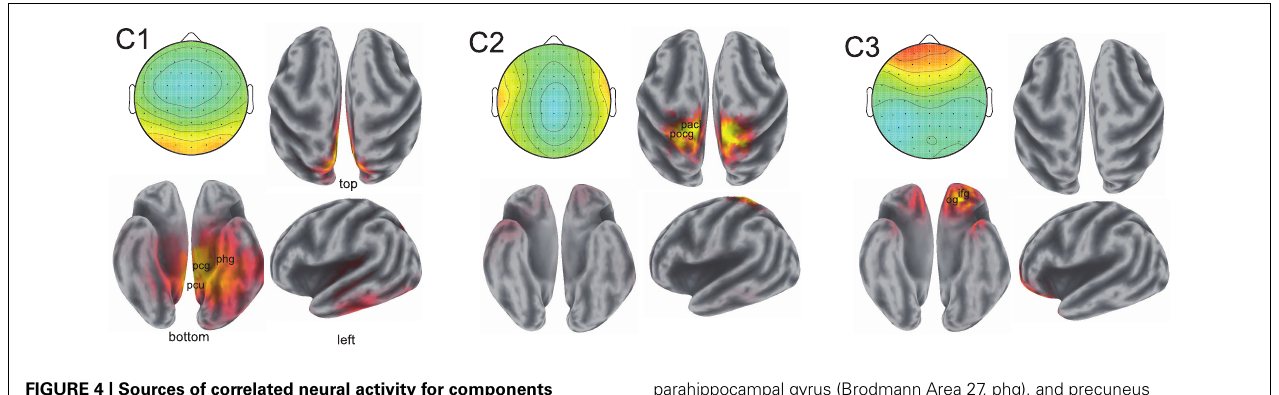
FIGURE 4 | Sources of correlated neural activity for components 1, 2, and 3. The scalp projections of the correlated activity are shown in the top left of each pane; the estimated distributions of cortical sources are depicted in the remaining three panes.The correlated activity of component 1 suggests involvement of the posterior cingulate gyrus (Brodmann Area 31, labeled pcg), the